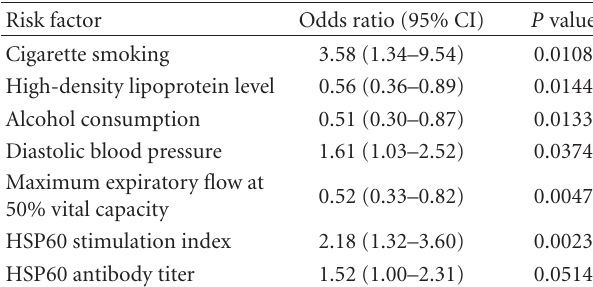
Table 2: Logistic regression analysis for the impact of various risk factors on high vascular intima-media thickness in a study of 141 young (17- or 18-year old) white males (see